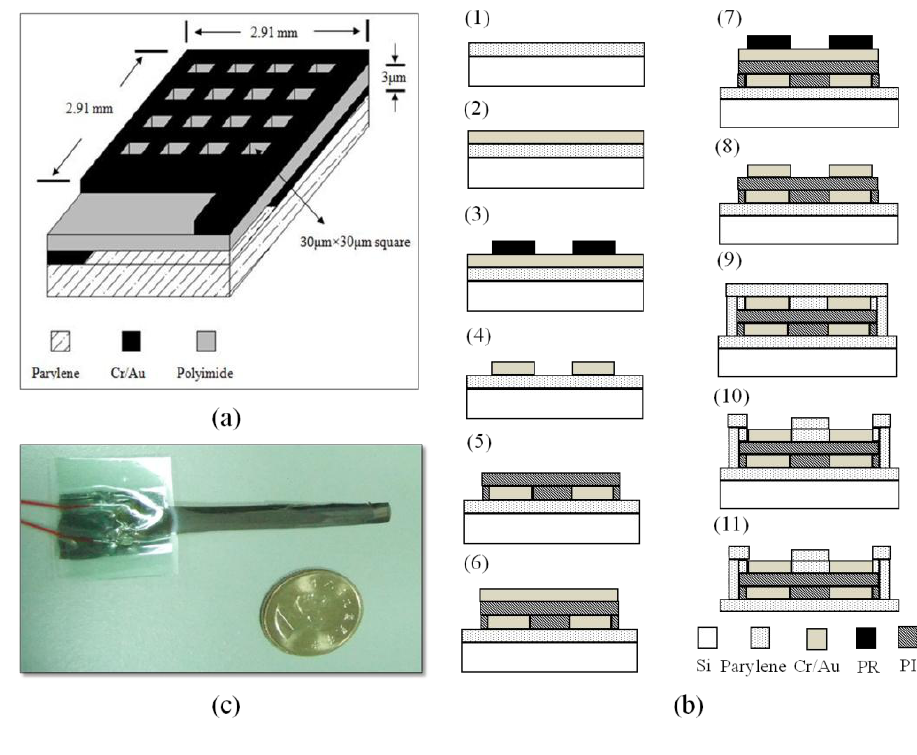
fabrication process for the humidity microsensor; and ( c ) Photograph of the humidity